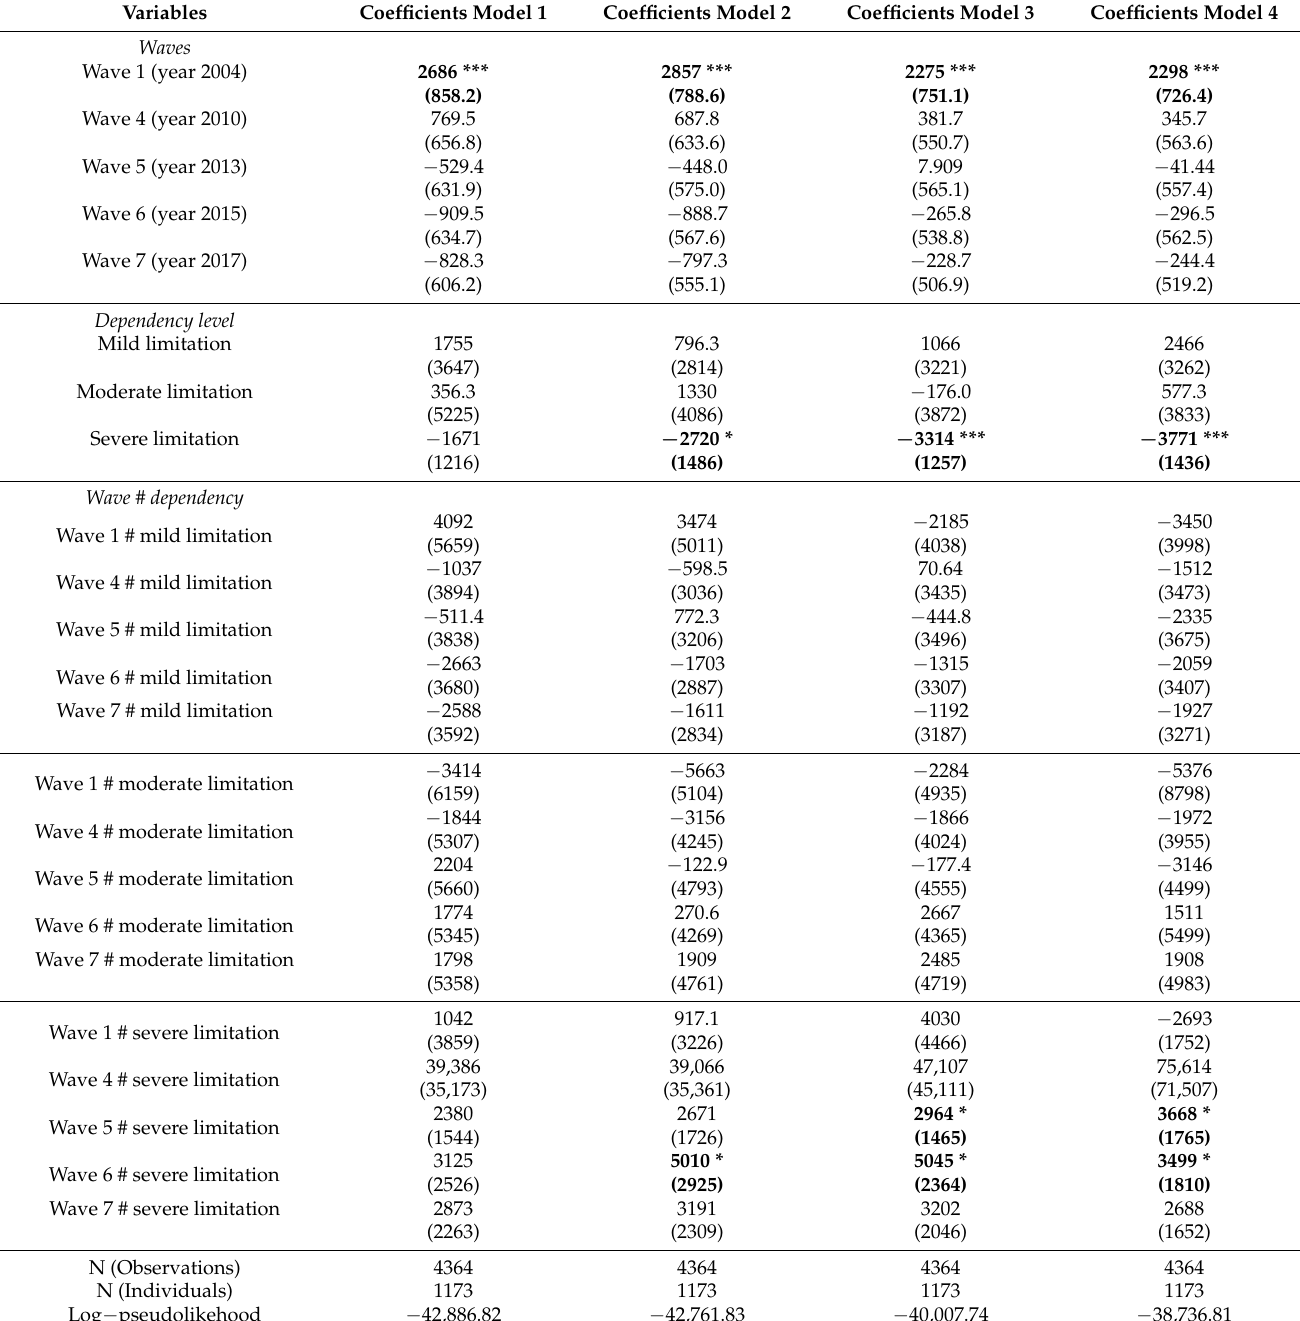
Table 2. Results from the GLM regression with Gamma distribution and identity link on household